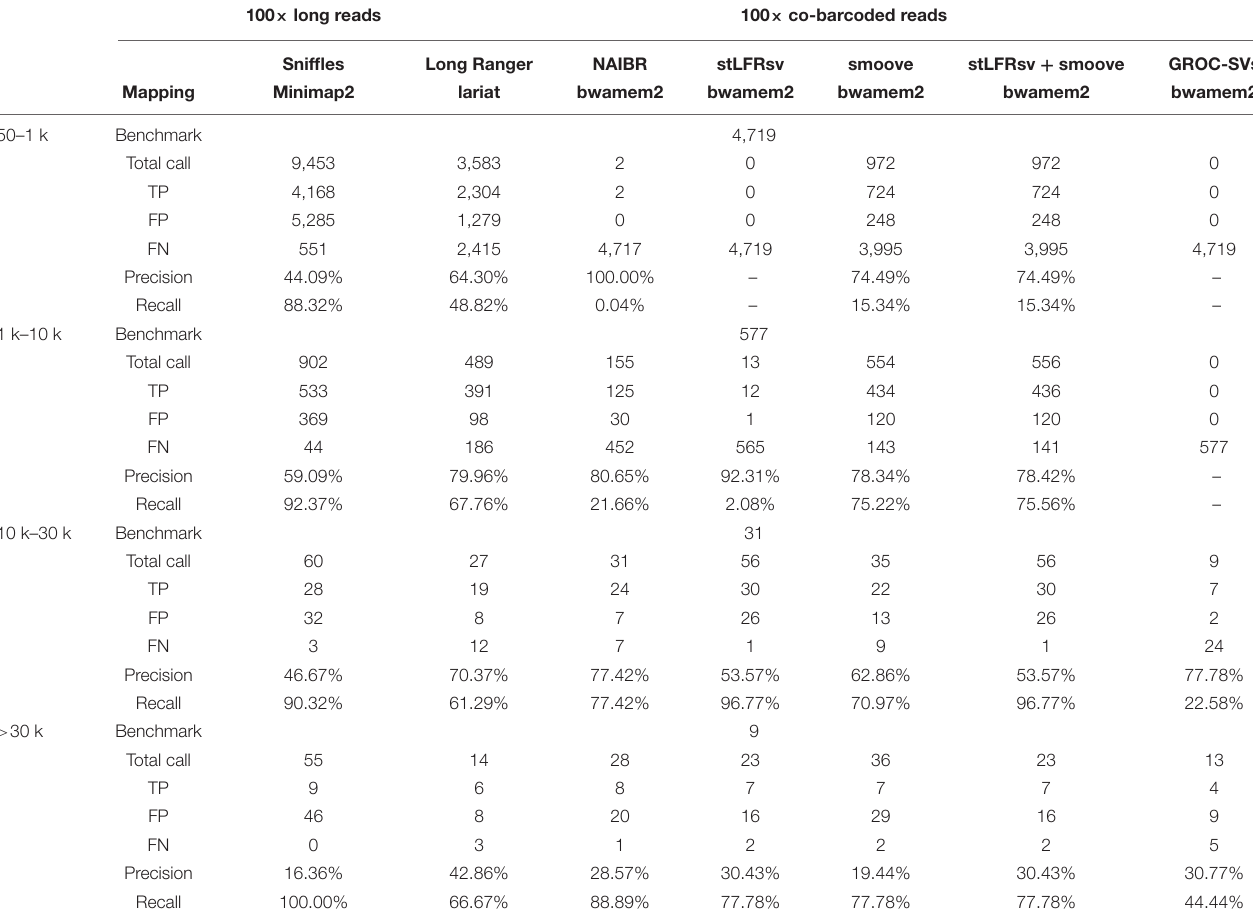
TABLE 1 | Deletion evaluation on whole genome against GIAB HG002 benchmark. 100 × long reads 100 × co-barcoded reads